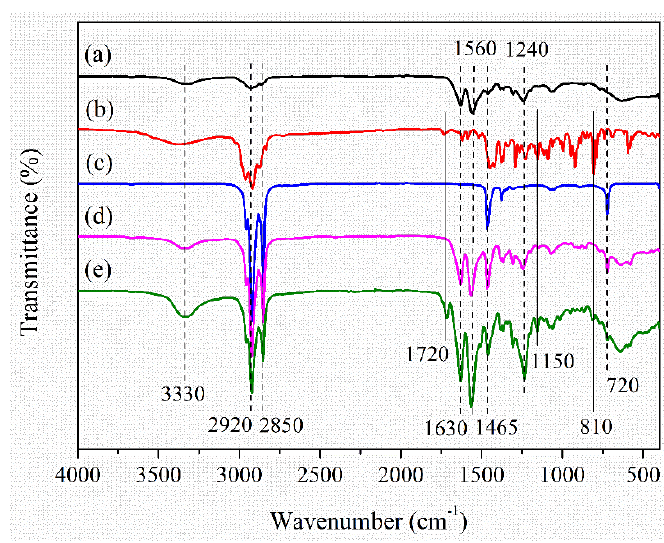
Figure 4. Fourier transform infrared spectrometer (FTIR) spectra of ( a ) PU polymer, ( b ) TO, ( c ) OD, ( d ) microPCMs and ( e ) antibacterial microPCMs.